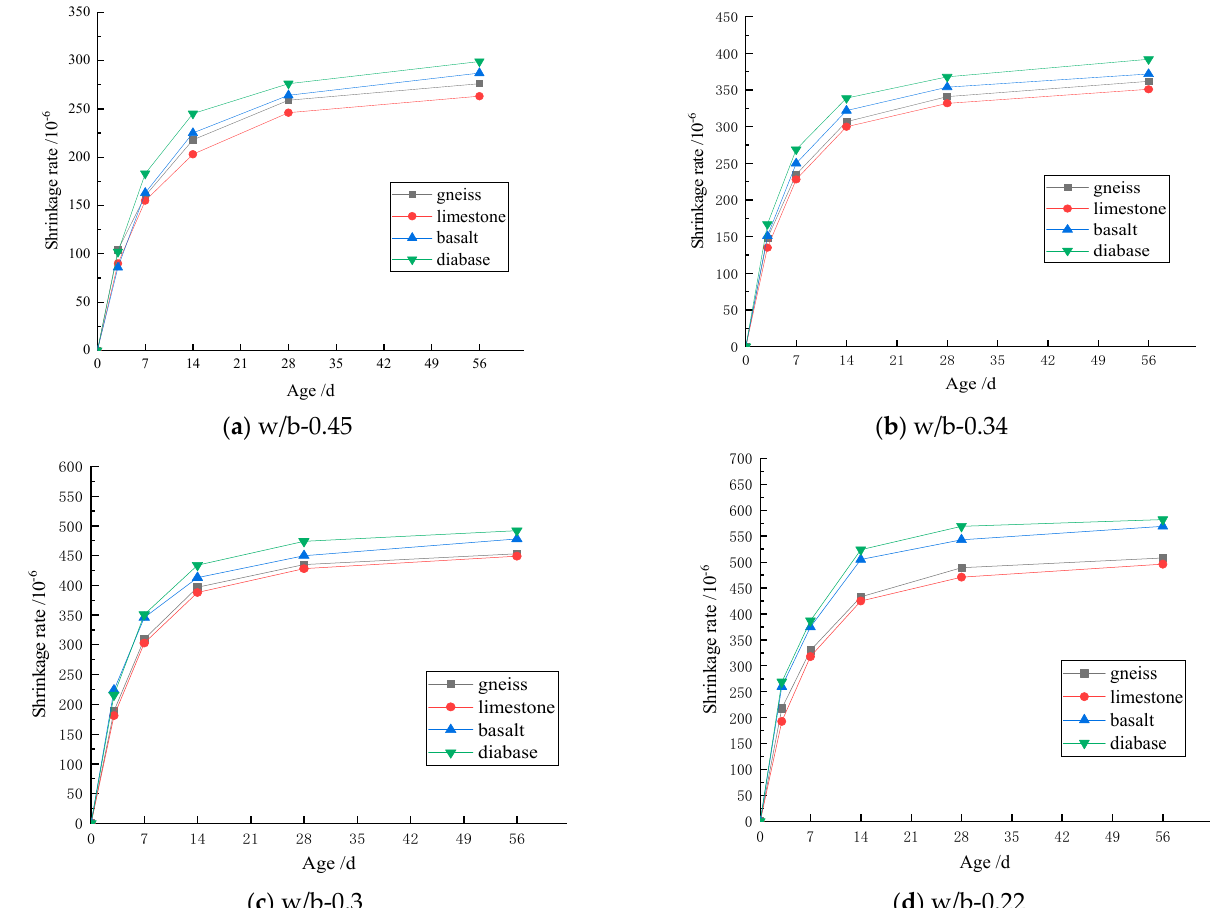
Figure 7. The shrinkage rate of coarse aggregate concrete: ( a ) water-binder ratio of 0.45; ( b ) water-binder ratio of 0.34; ( c ) water-binder ratio of 0.30 and ( d ) water-binder ratio of 0.22.